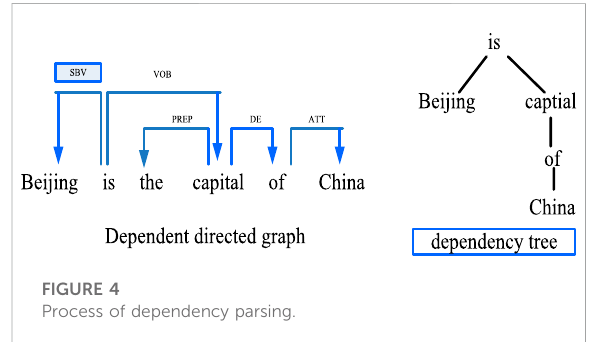
FIGURE 4 Process of dependency